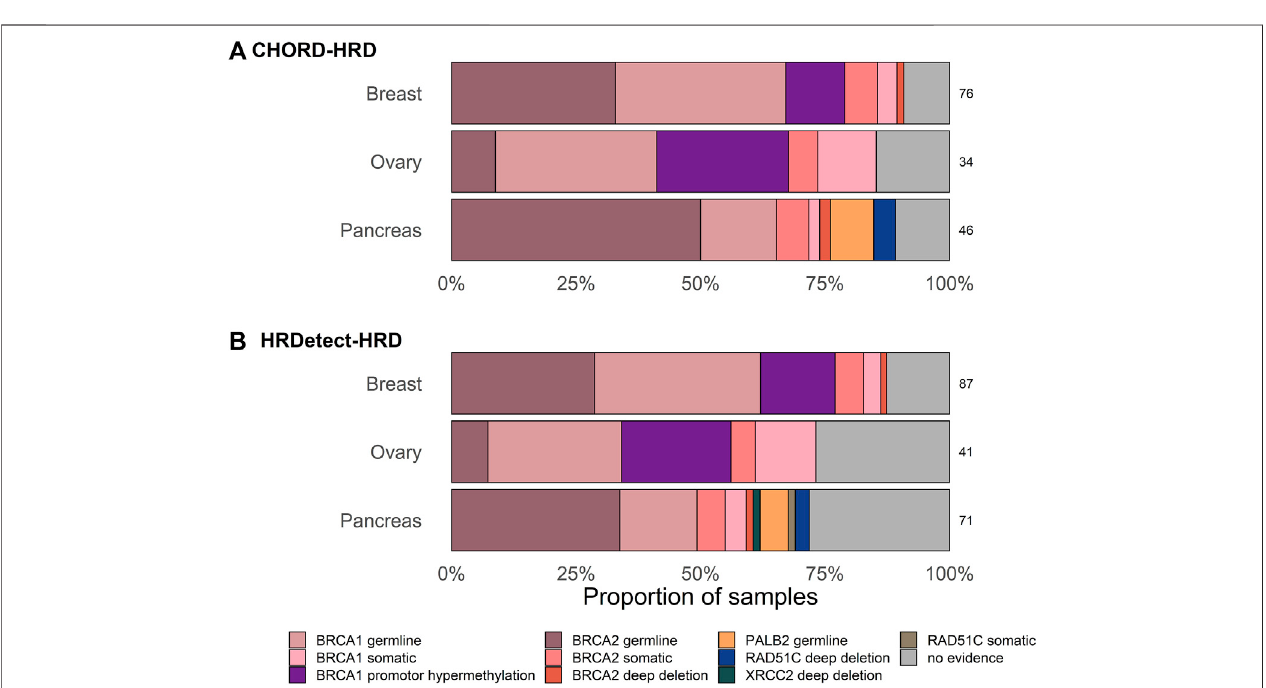
FIGURE 2 | Proportion of samples with and without biallelic alteration in HR-genes classi fi ed as HR-de fi cient with default threshold of (A) HRDetect of 0.7 and (B) CHORD classi fi ers of 0.5. Only one alteration in the gene is shown per sample based on the hierarchical order of genes as follows: BRCA1 , BRCA2 , RAD51C , PALB2, and XRCC2